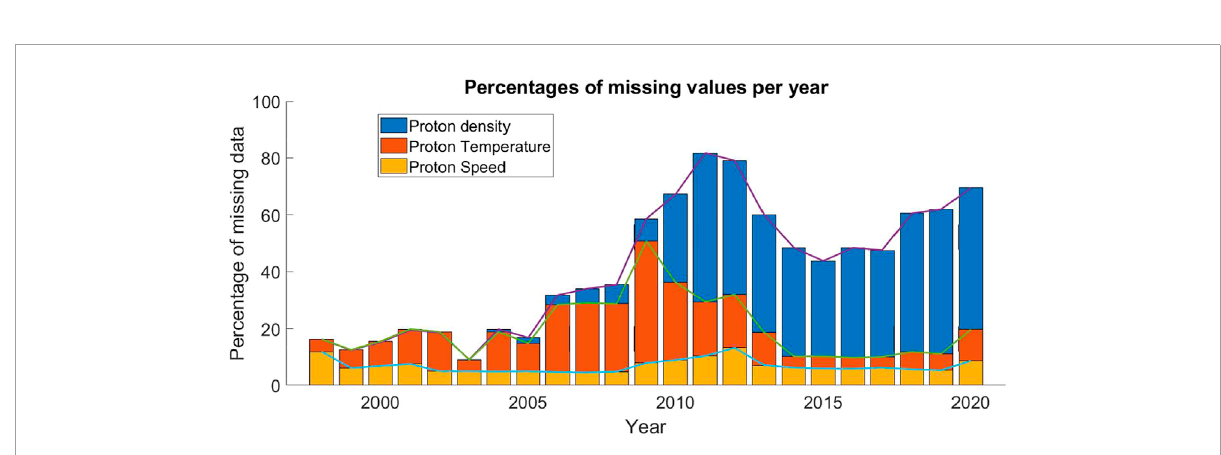
FIGURE 6 Percentage of data that are missing in the SWEPAM measurements (i.e., proton speed, proton density, and proton temperature) per year, from 1998 to